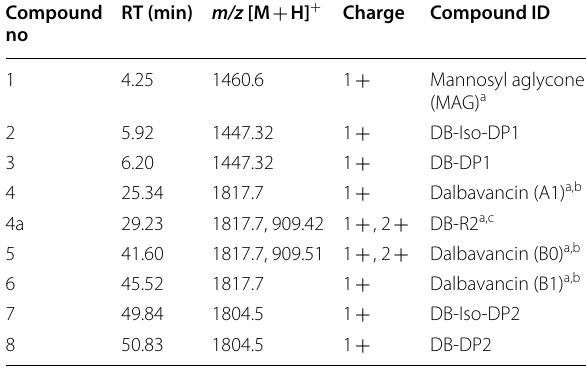
Table 3 Summary of the observed degradation products of dalbavancin after stressing at 70 °C for 5 days in 10 mM acetate and 3 days in 10 mM phosphate